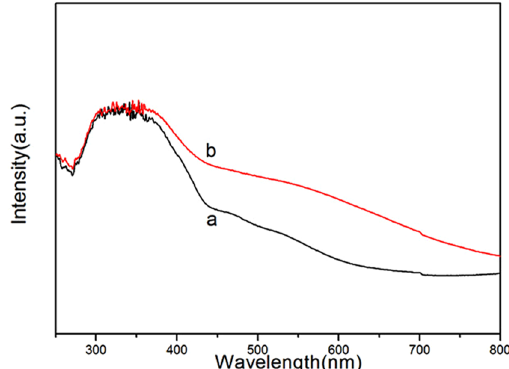
Figure 3. Diffuse reflectance spectra of Fe-based MOFs ( a ) MIL-101(Fe) and ( b ) NH 2 -MIL-101(Fe).